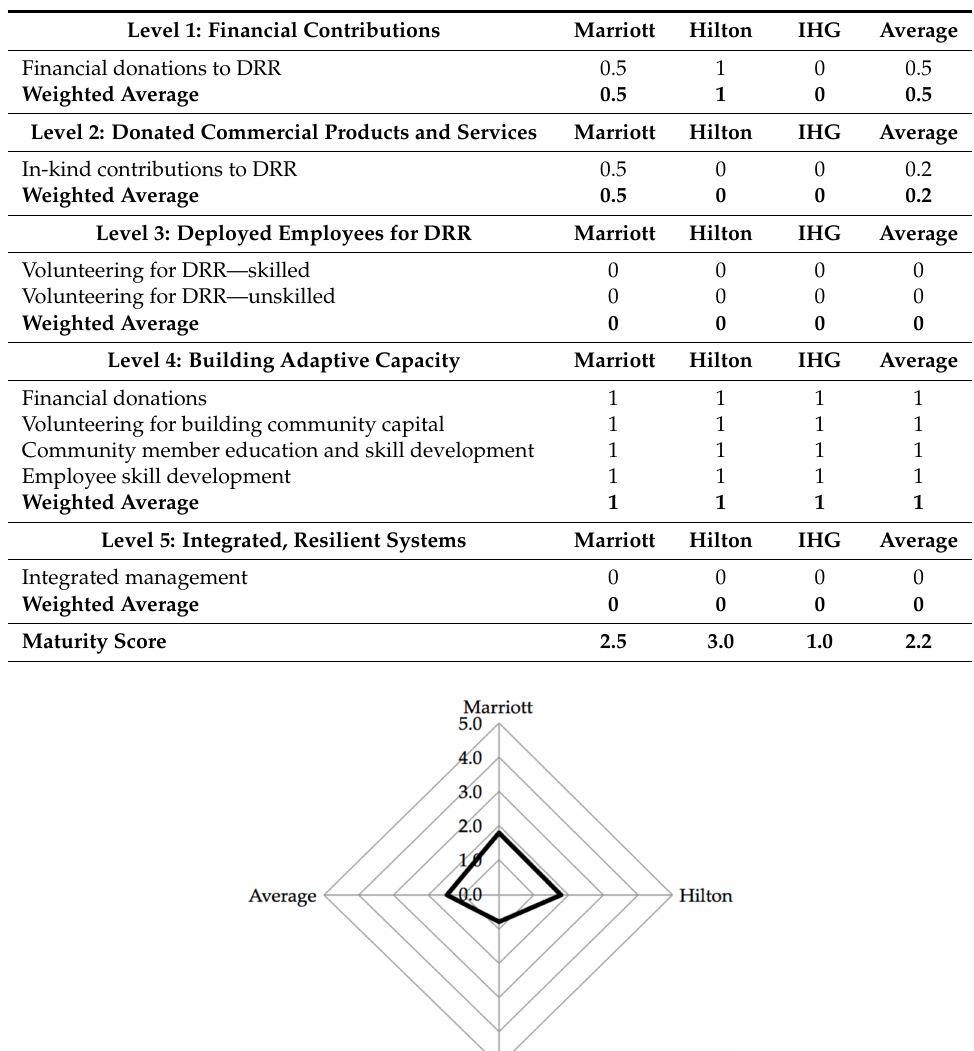
Table 1. Scoring breakdown for the vision/policy statement and goal analysis. DRR: disaster response and recovery, IHG: InterContinental Hotels Group.